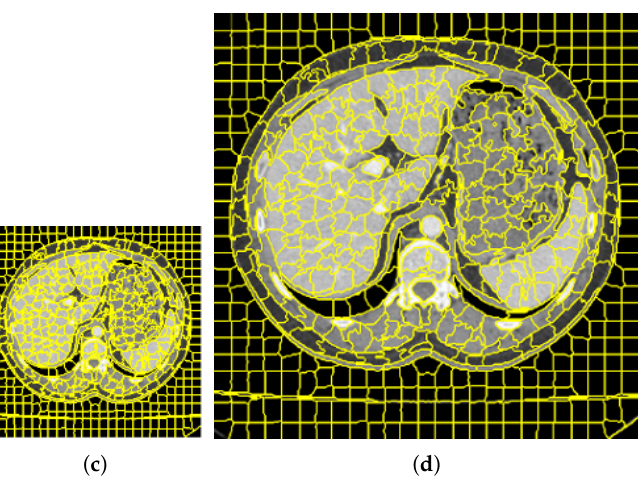
Figure 2. The results of downscaling segmentation and restoring to the original scale. ( a , c ) represent the pictures after downscaling, respectively, ( b , d ) represent the pictures restored to the original scale, ( a , b ) are the original images of the label image, ( c , d ) are the pictures obtained after